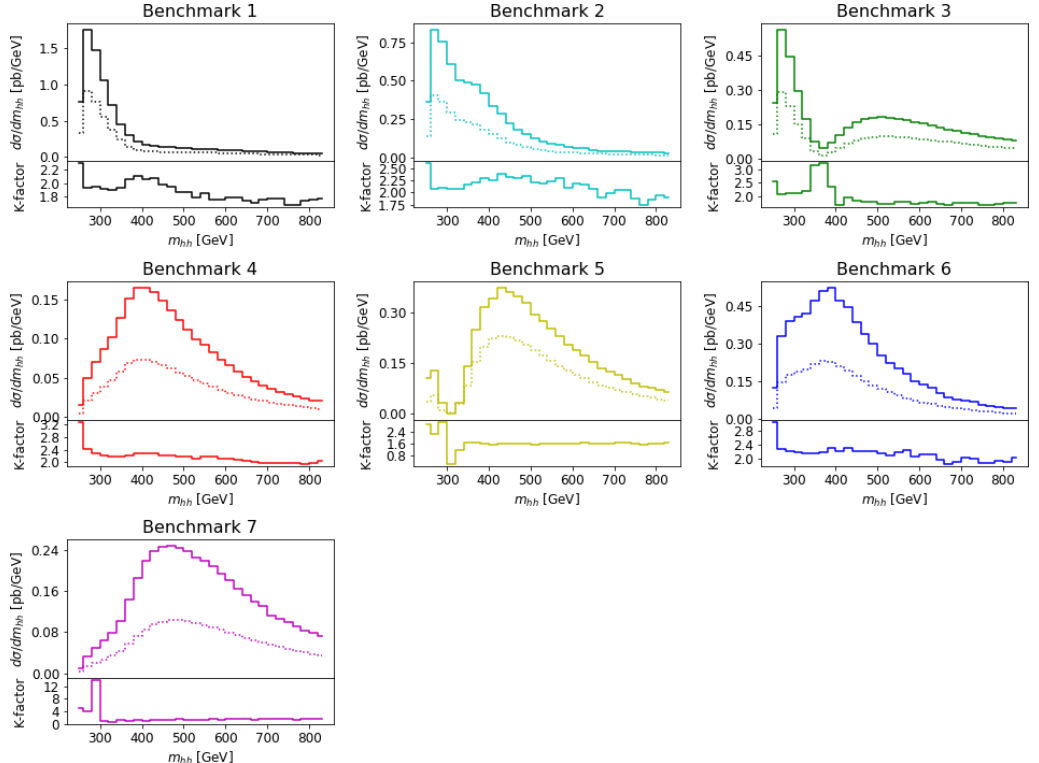
Figure 19 . Higgs boson pair invariant mass distributions corresponding to the benchmark points listed in table 3.3. The solid curves denote the NLO result, the dotted curves the LO result. The lower panels show the K-factor, de(cid:12)ned as d(cid:27) NLO =d(cid:27) LO